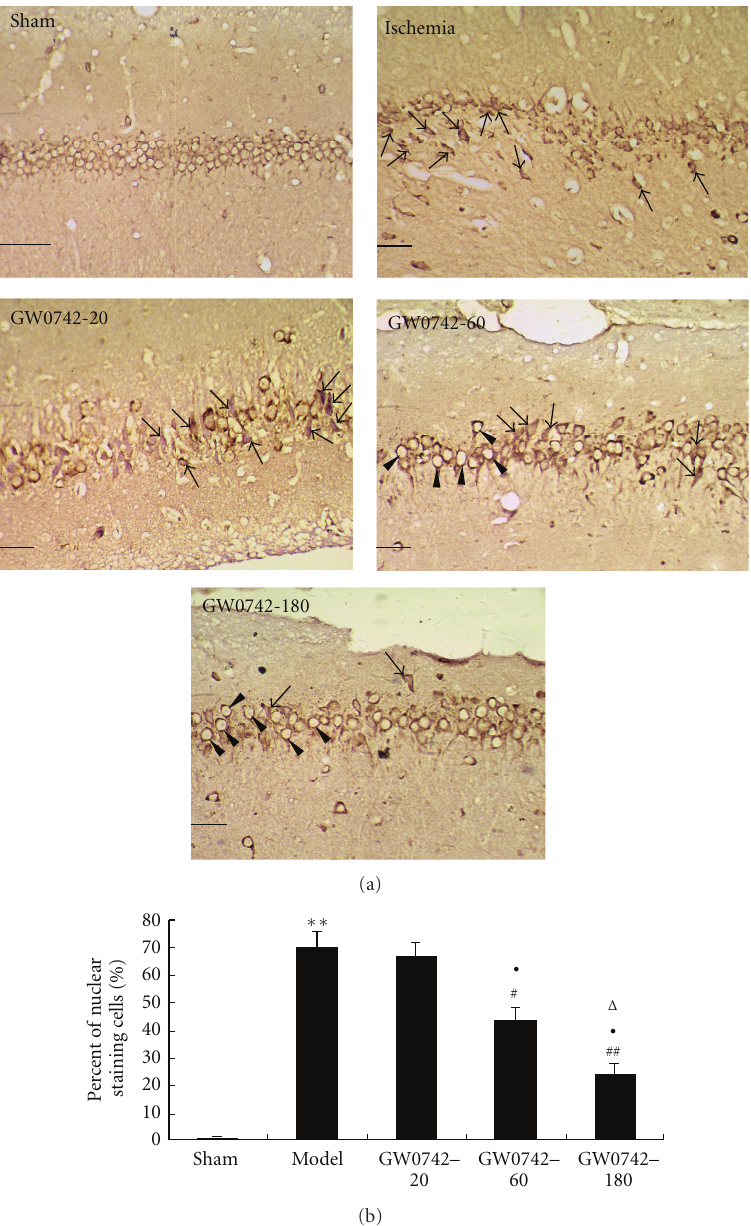
Figure 2: GW0742 inhibits the GCIRI-induced expression and nuclear translocation of NF- κ B in the hippocampus. (a) Representative images of the hippocampal CA1 region after GCIRI. Once NF- κ B is activated, it translocates into the nucleus. In the vehicle sham group (Sham), weak cytosolic staining was observed, but no obvious nuclear staining was seen. In the vehicle model animals (Ischemia) and the GW0742-20 model group (GW0742-20), NF- κ B staining was significantly increased and was seen in the nucleus in most of cells, see the arrow-pointed cells and cytosol. In the GW0742-60 model group (GW0742-60), cells with nuclear NF- κ B staining were deceased compared with the vehicle model group. In the GW0742-180 model group (GW0742-60), staining was mostly confined to the cytosol (see the arrow head-pointed cells) with very faint staining in the nucleus (scale bars = 50 μ m). (b) Group data showing the e ff ect of GW0742 on NF- κ B expression and translocation. ∗∗ P < 0 . 01 compared with vehicle sham group; # P < 0 . 05, ## P < 0 . 01 compared with vehicle model group; Δ P < 0 . 05 compared with GW0742-20 model group; • P < 0 . 05 compared with GW0742 60 model group, ( n =